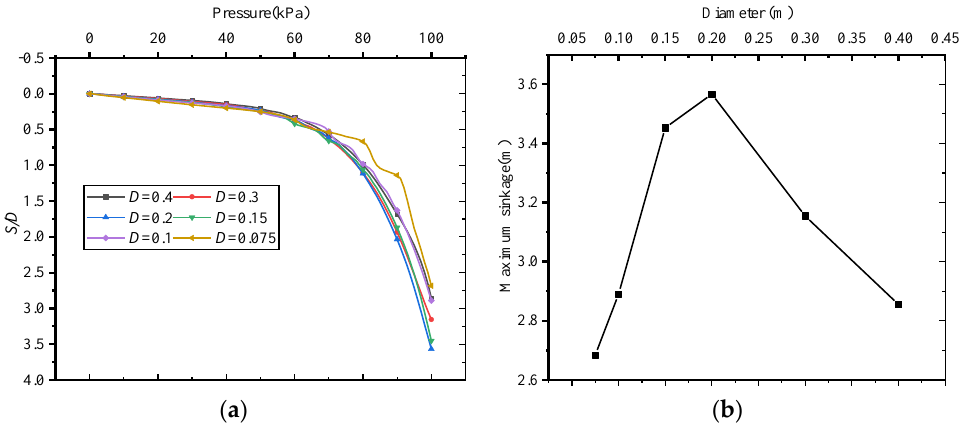
Figure 21. Pressure-sinkage curves of different circular plate diameters. Similar to the rectangular plate, the diameter of the circle plate and the sinkage was normalized in this section, and the relation curve between different pressures and S/D is obtained. It can be found from the Figure 22a, different from the rectangular plate, the relationship between the ratio of the sinkage to the plate width and the pressure varies greatly under different diameters. On the other hand, it can be seen from the Figure 22b that the relationship between the plate diameter and the maximum sinkage is nonlinear with no convergence phenomenon. Comparing with the data of the rectangular plate, the normalized data results of rectangular plate and circular plate are different. Therefore, the calculation results of a rectangular plate and a circle plate cannot be completely equiva- lent.